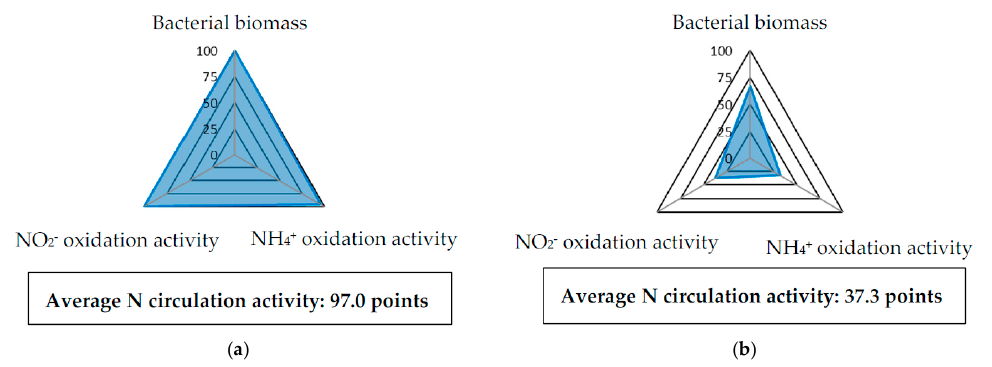
Figure 1. Average nitrogen circulation activity in ( a ) organically managed soils and ( b ) conventionally managed soils.